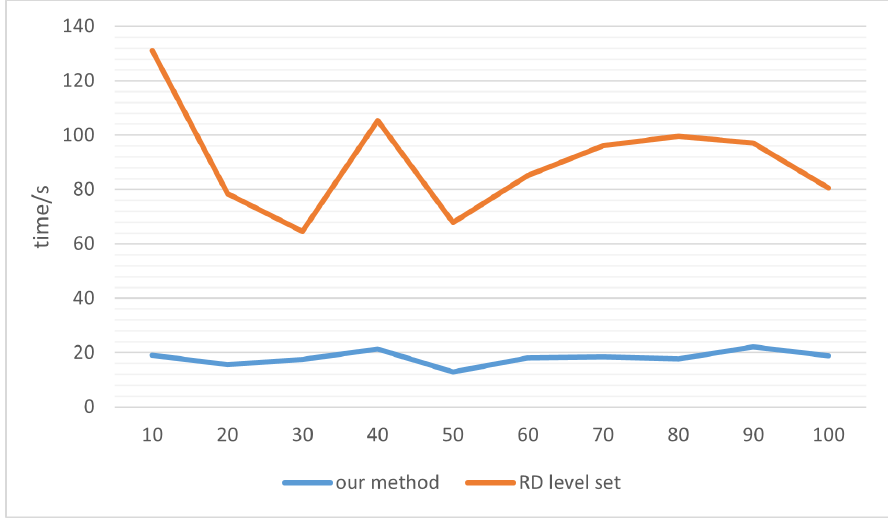
Figure 8. Time complexity of our method and RD level